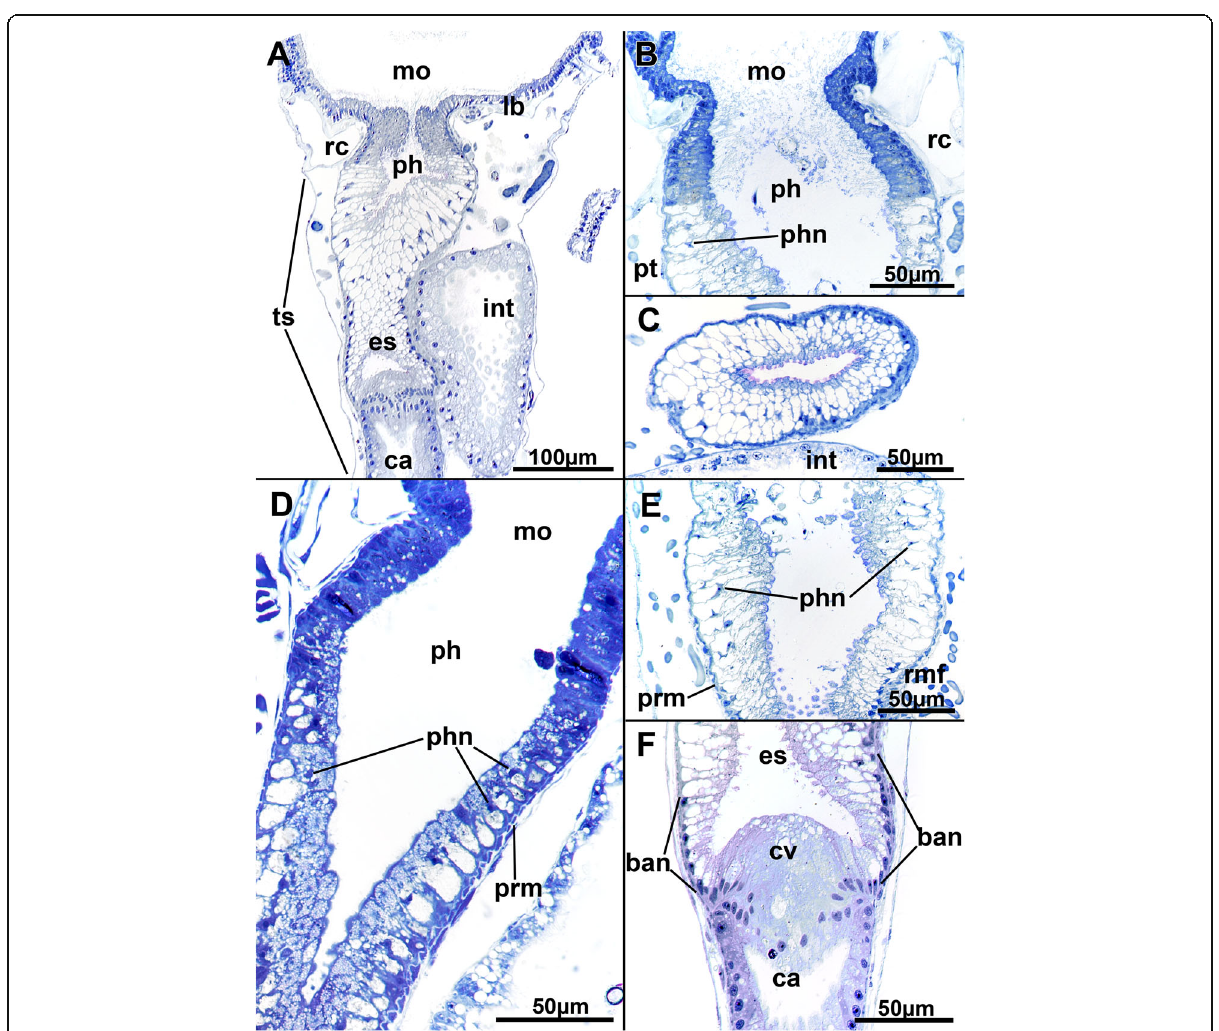
Fig. 10 Histological details of the foregut of Stephanella hina . a Longitudinal section of an extended polypide showing the mouth opening, foregut until the cardia, and intestine. b Detail of a mouth opening and pharynx area in a zooid with retracted polypide. The nuclei of the pharynx appear pycnotic and are wedged between large vacuoles in the cells of the epithelium. c Cross-section of a pharynx showing the highly vacuolar appearance of its epithelium. d Longitudinal section of the mouth opening and pharyngeal area showing a high abundance of smaller vesicles in the apical part of the pharyngeal epithelial cells. e Detail of the lower part of the pharynx entering the esophagus. f The esophageal- cardia boundary is marked by the cardiac valve. On the esophagus, basally located nuclei are present in its cells. Abbreviations: ban - basal nuclei, ca - cardia, cv - cardiac valve, es - esophagus, int - intestine, lb. - lophophoral base, mo - mouth opening, ph - pharynx, phn - nucleus of the pharynx, prm - pharyngeal ring muscles, rc - ring canal, rmf - retractor muscle fibres, ts - tentacle